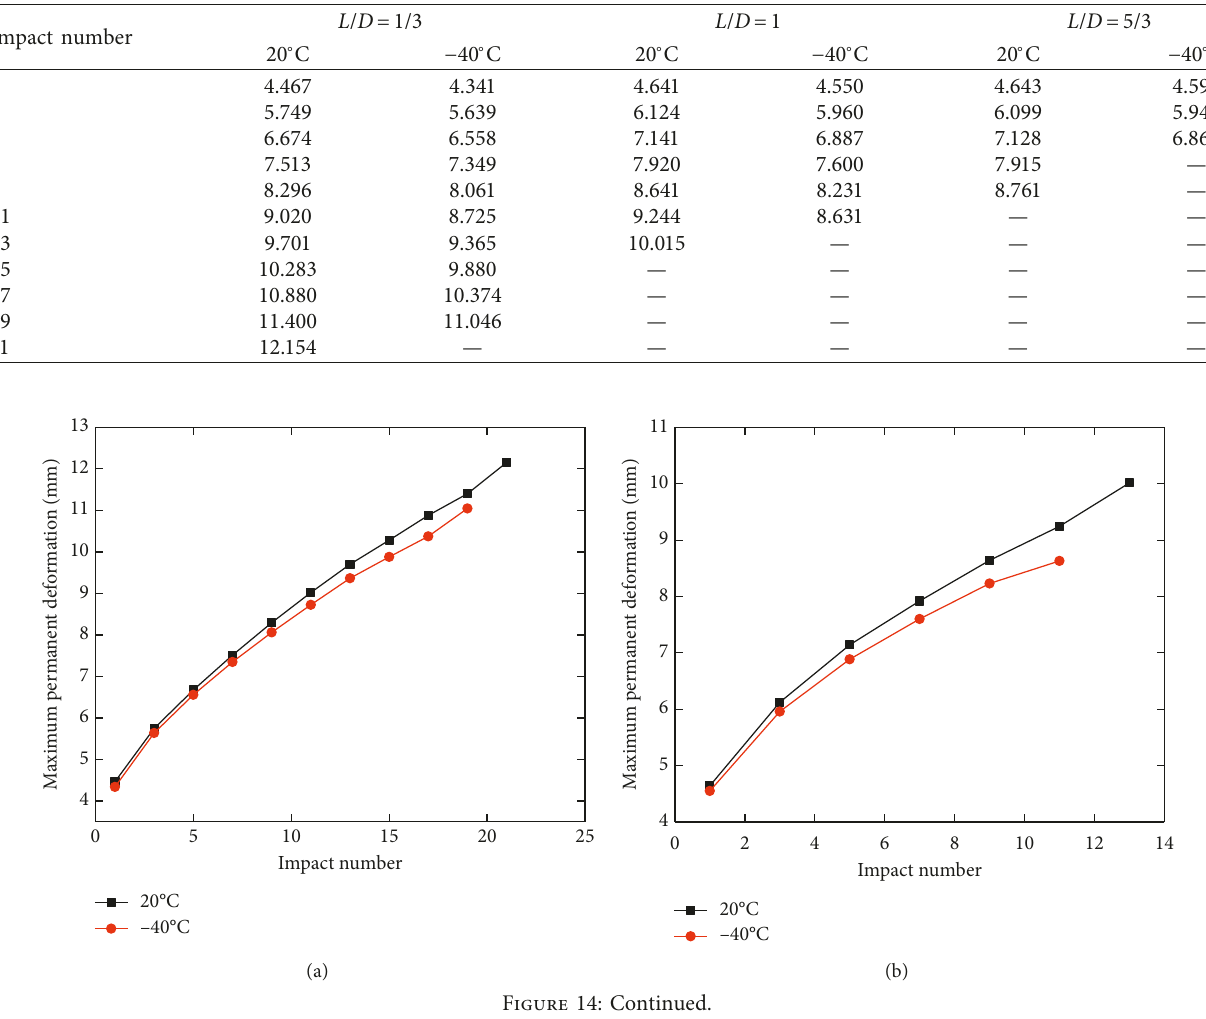
Figure 13: Comparison of the maximum impact force at different temperatures. Table 2: Maximum lateral plastic deformation at different temperatures (unit: mm).